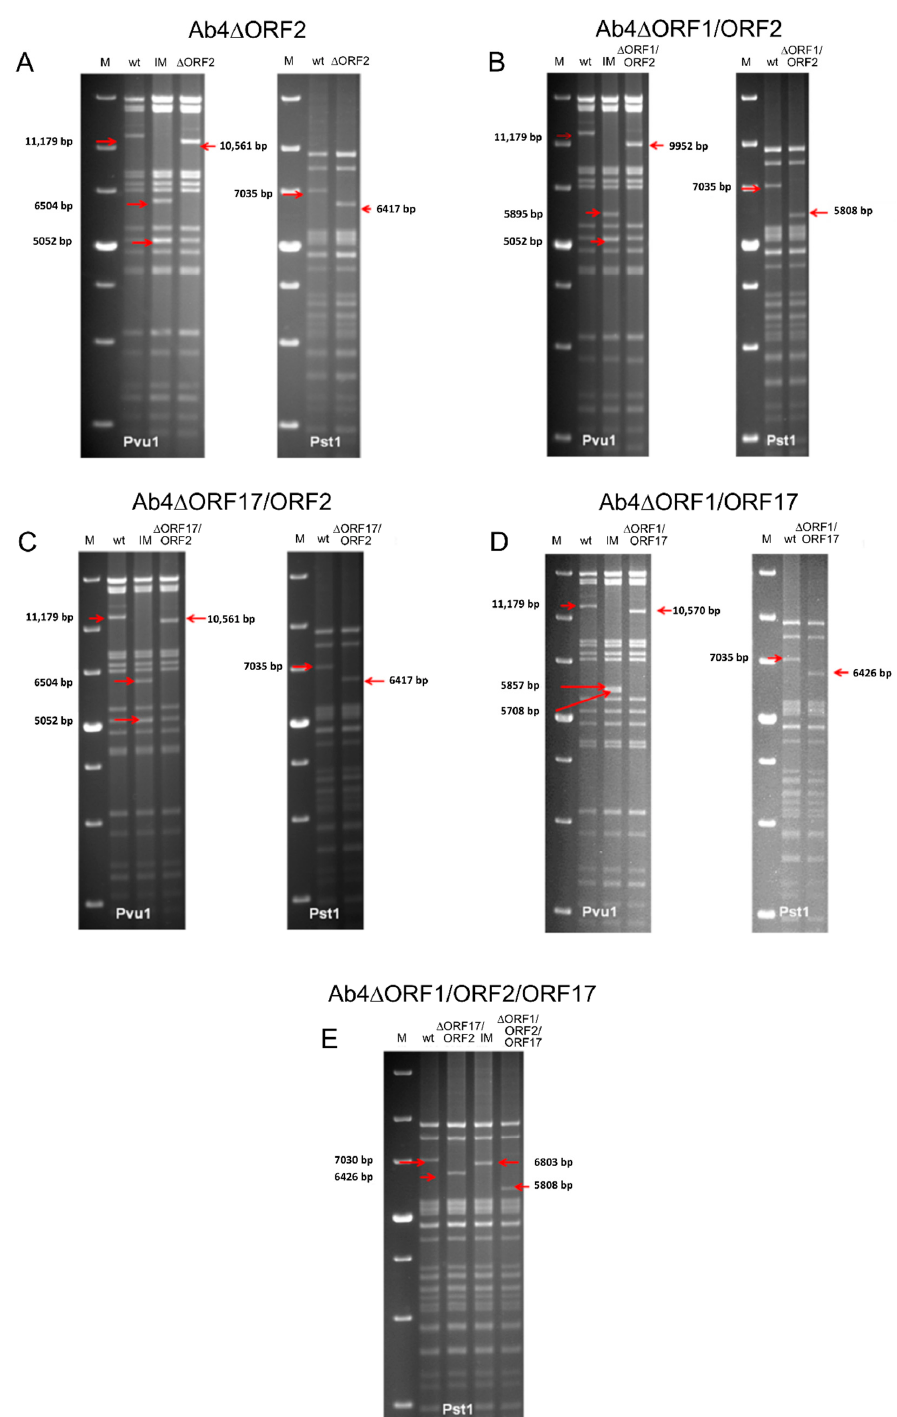
Figure 1. Restriction fragment length polymorphism (RFLP) analysis for characterization of constructed BAC mutants. Purified DNAs from Ab4-wt, intermediate clone with kanamycin cassette and final clone with gene deletion BAC were digested with Pst1 and Pvu1 . Fragments in the intermediate and final mutant clones that appeared as a result of the deletion of sequence were marked by red arrows. Construction of ( A ) Ab4 ∆ ORF2, ( B ) Ab4 ∆ ORF1 / ORF2, ( C ) Ab4 ∆ ORF17 / ORF2, ( D ) Ab4 ∆ ORF1 / ORF17 and ( E ) Ab4 ∆ ORF1 / ORF2 / ORF17 BAC mutants. M—1 kb plus DNA ladder (Thermo Fischer Scientific, Paisley, UK), wt—EHV-1 Ab4 strain wildtype virus, IM—intermediate BAC clone with kanamycin cassette insertion, ∆ —specific gene deletion and arrow—band